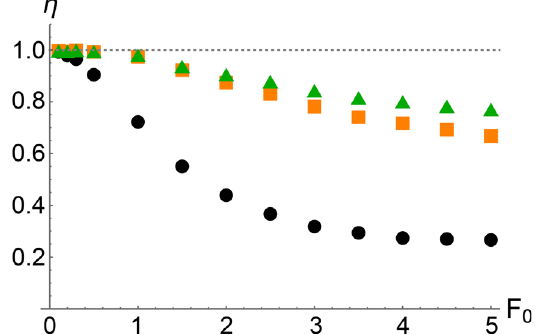
FIG. 6. The ratios defined in Eq. (48) for the current in the longitudinal direction in the channel potential Eq. (53) as a function of the bias force F 0 . The black circles correspond to the TUR and the green triangles and orange squares to the CTUR with the approximate local mean velocity given by Eqs. (58) and (60), respectively. The data are obtained from Langevin simu- lations with k ¼ 1 , L ¼ 1 , α ¼ 0 . 8 , and k B T ¼ 0 . 5 for 10 5